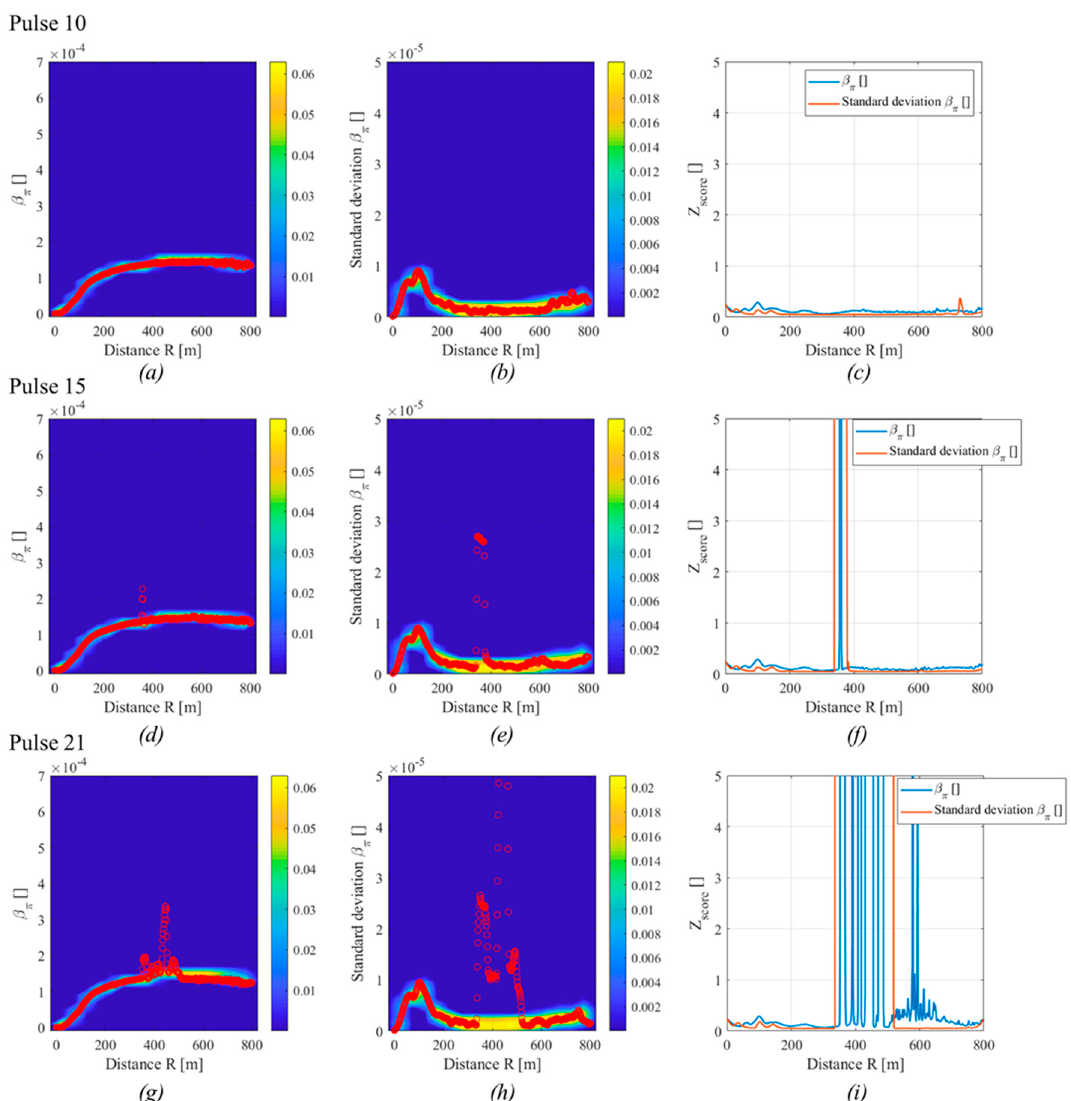
Figure 5. Signals of the backscattered coefficient amplitude ( a,d,g ) and standard deviation ( b,e,h ) on the pdf map with the signal value in red circles and signals of the Z score ( c,f,i ) for the pulses 10 ( a–c ), 15 ( d–f ) and 21 ( g–i ).